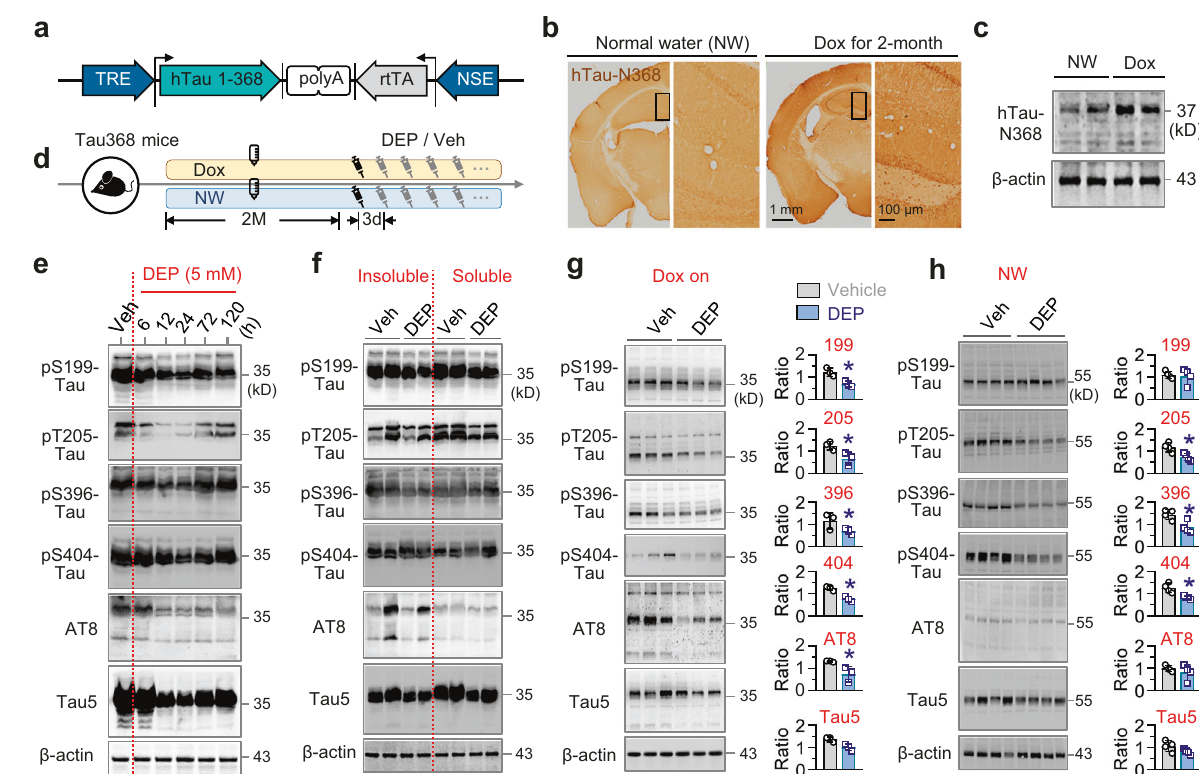
Fig. 3 DEPTAC reduces phosphorylated and total tau in the hippocampus of Tau368 mice. a The expression of hTau-N368 was controlled by the NSE promoter and a tet-on system. b , c Prominent hTau-N368 expression was detected by immunohistochemistry ( b ) and Western blotting ( c ) in the dorsal hippocampus of the dox-, but not normal water (NW)-drinking group. d Experimental procedures for drugs administration. DEPTAC or vehicle was administrated for once or a consecutive month during dox on. e DEPTAC for once reduced phosphorylated and total tau prominently at 5 mM and 12 – 72 h of post intra-cerebroventricular injection in the hippocampus of Tau368 mice. f DEPTAC decreased both soluble and insoluble tau in the hippocampus of Tau368 mice. g , h DEPTAC for a consecutive signi fi cantly reduced hippocampal phospho-tau and total tau (/ 10 μ g total protein) after dox administration for 4 months ( g ), while the ef fi ciency of DEPTAC on mouse tau was relatively limited in NW-administrated Tau368 mice (/ 30 μ g total protein) ( h ). Unpaired t -tests, * p < 0.05, n = 3 – 4 mice